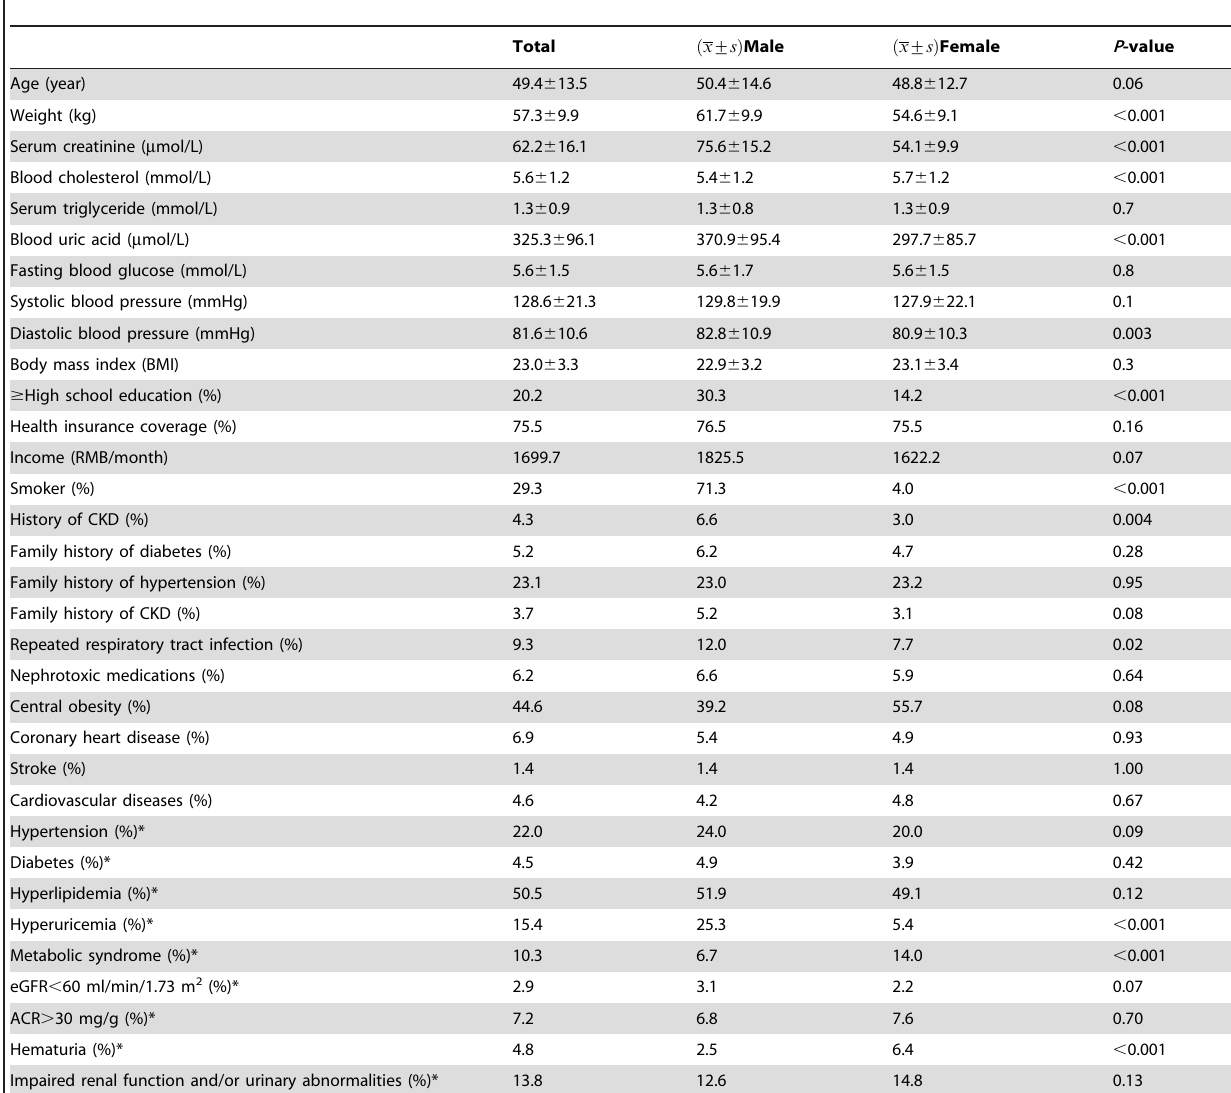
Table 1. Sociodemographic and clinical characteristics of the study population.